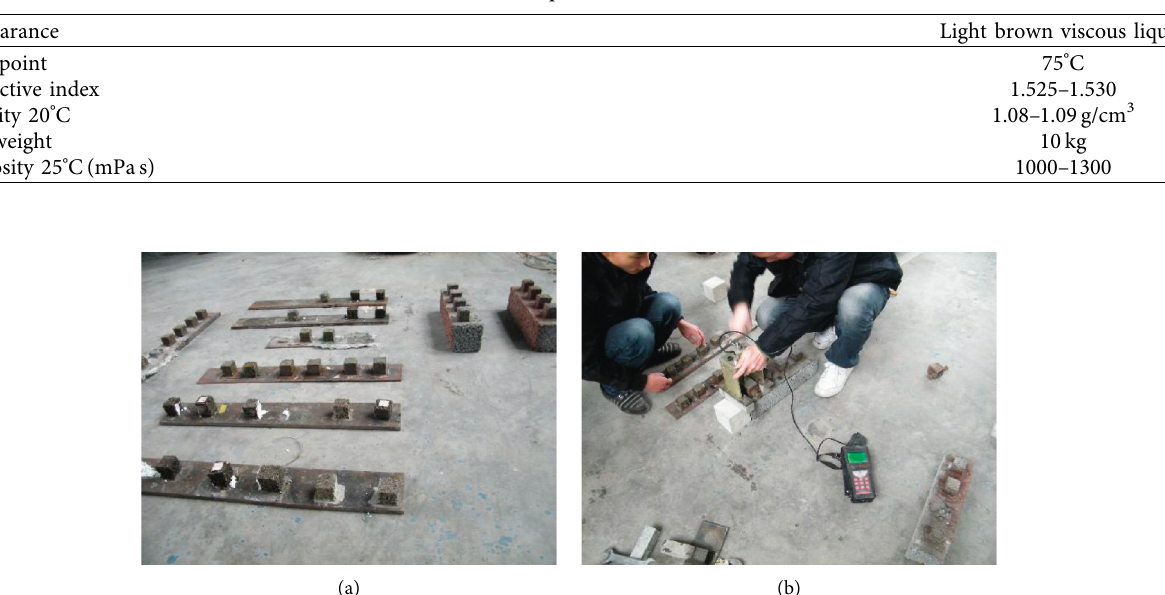
Table 2: Basic parameters of T-31.